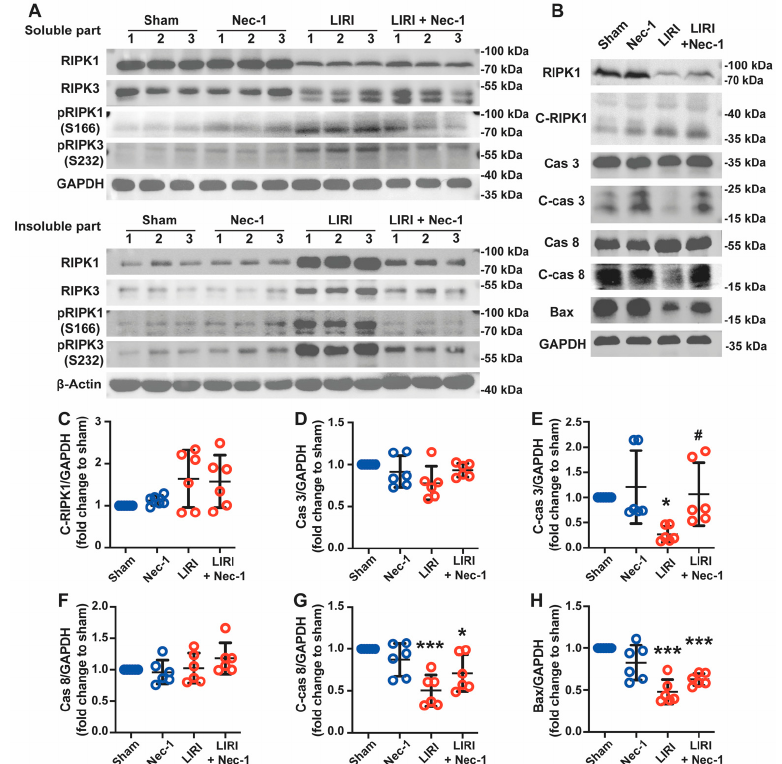
Figure 5. Necrostatin-1 inhibited the formation of necrosome but promoted apoptosis in mouse LIRI. The mouse LIRI was induced by clamping the left pulmonary hilum of the mouse for 1 h using a microvascular clip and then removing the clip for reperfusion for 2 h. Nec-1 (1 mg/kg) was administered intraperitoneal injection 1 h before ischemia. ( A ) Western blotting of RIPK1, phosphor- RIPK1, RIPK3, and phosphor-RIPK3 in soluble parts (upper panel) and insoluble parts (lower panel) of lung tissue homogenates. n = 3 animals per group. ( B ) Western blotting of apoptosis-related proteins (cleaved RIPK1, caspase 3, cleaved caspase 3, caspase 8, cleaved caspase 8, and Bax) in lung tissue homogenates. ( C − H ) Quantification of proteins from Western blots in panel B. n = 6 animals per group. * p < 0.05, ** p < 0.01, *** p < 0.001, compared with Sham; # p < 0.05, ## p < 0.01, ### p < 0.001, compared with LIRI; One-way ANOVA.